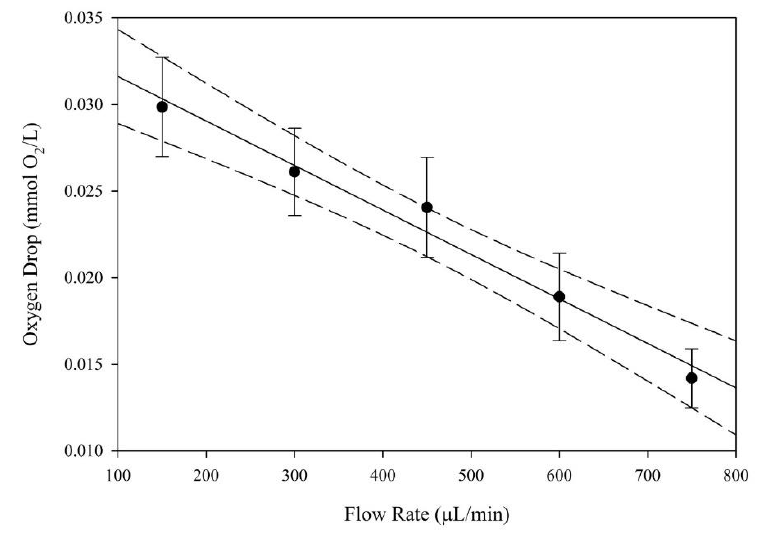
Figure 2. Oxygen drop across the construct.